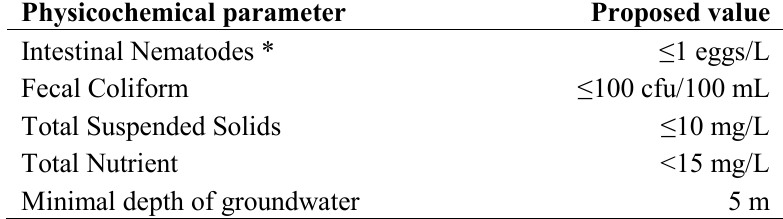
Table 1. Proposed criteria for groundwater recharge using reclaimed wastewater in Greece